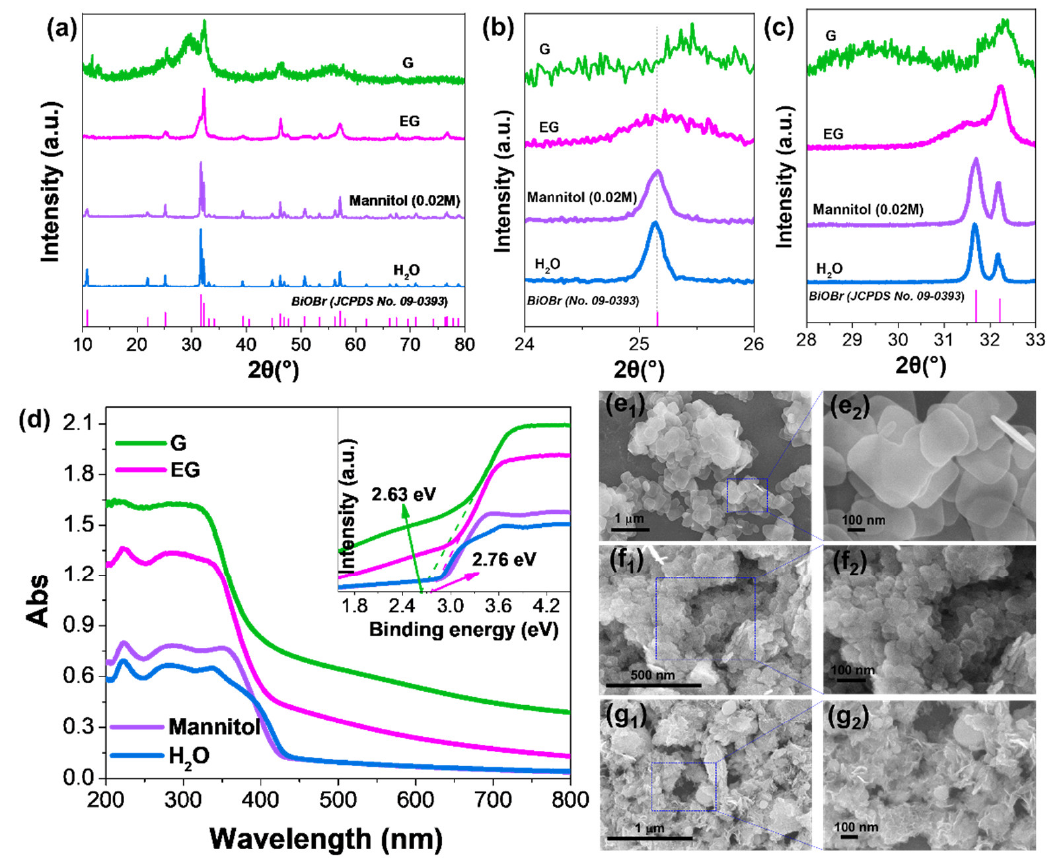
Figure 2. Comparison of different products prepared in different solvents, ( a ) XRD patterns, corre- sponding enlarged range of ( b ) 24–26 ◦ and ( c ) 28–33 ◦ . ( d ) DRS spectra (inset with corresponding estimated bandgaps). SEM images of ( e 1 ) and ( e 2 ) mannitol (0.02 M), ( f 1 ) and ( f 2 ) EG, and ( g 1 ) and ( g 2 ) G.